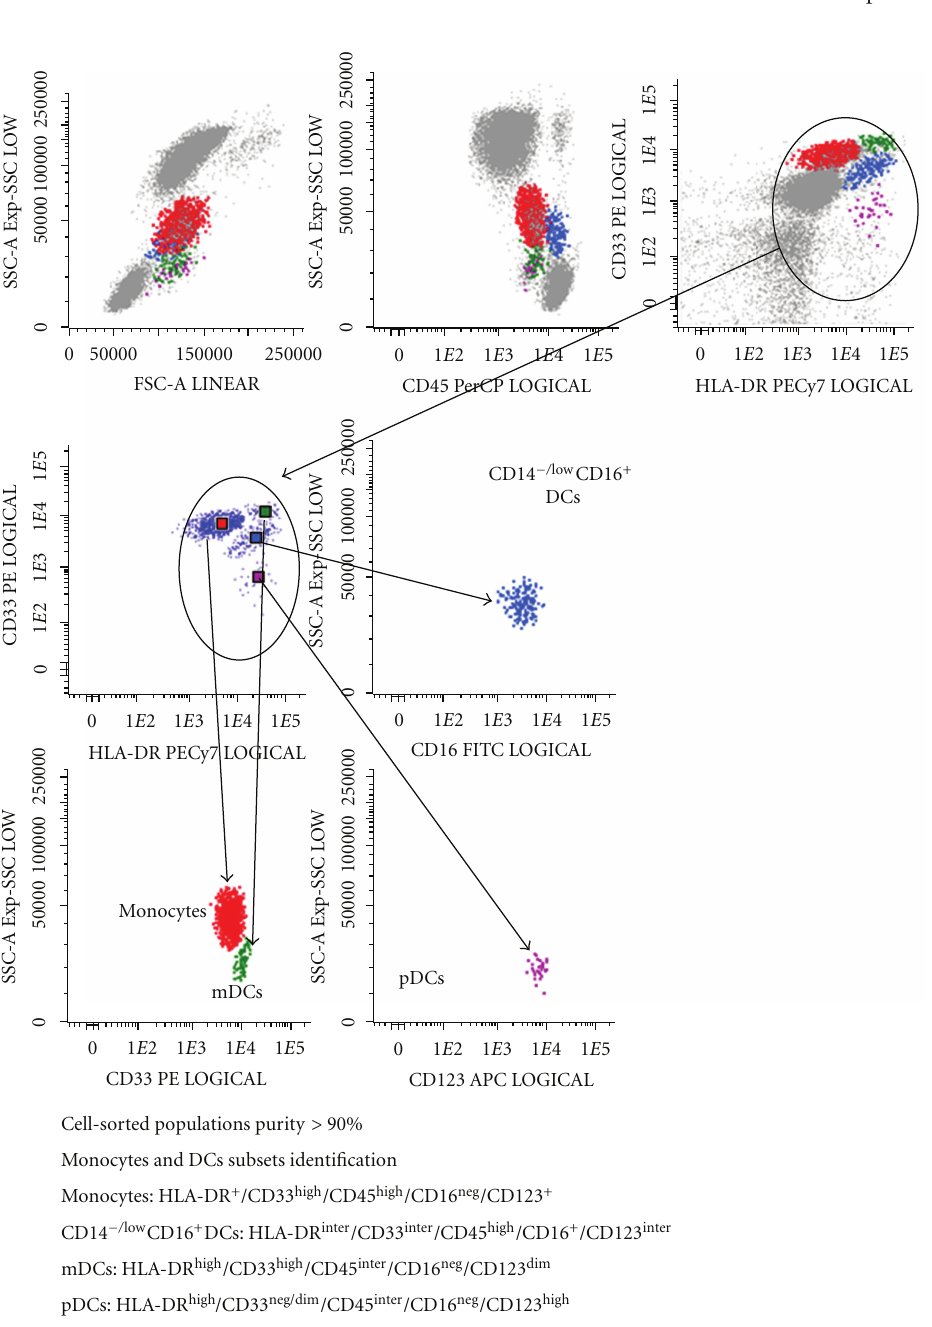
Figure 1: Flow cytometry gate strategy to obtain purified monocytes and peripheral blood dendritic cells by cell sorting. CXCL9, and CXCL10 on mDCs and CD14 − / low CD16 + dendritic cells and of IFN- α and ICOSL on pDCs (Table